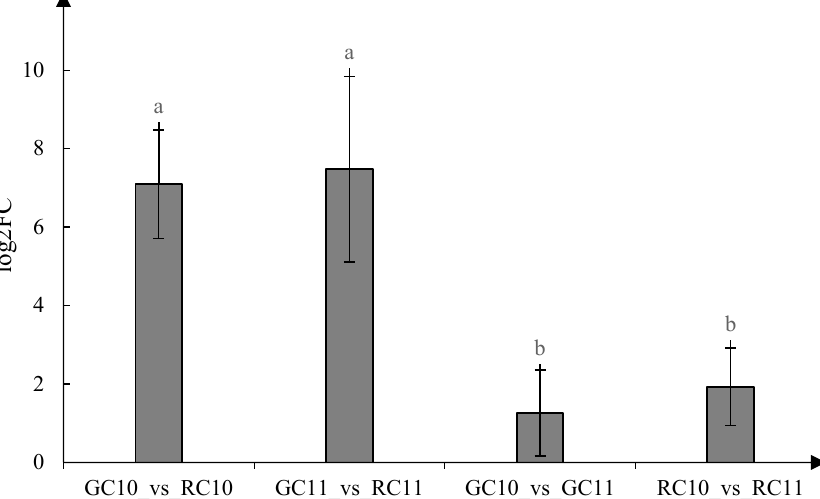
Figure 4. Differences in VvMYBA1 expressions in red and white grape berry skins. ‘GC’ represents three green cultivars; ‘RC’ represents three red cultivars. a, b represent the significant level between the data ( p <0.05).